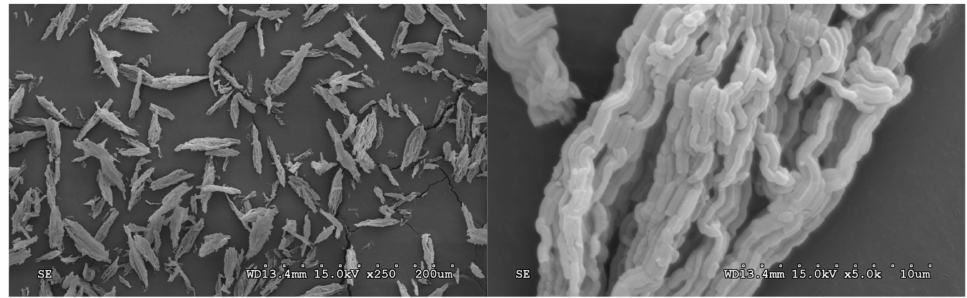
Figure 15. SEM micrographs of the synthesized SBA-15 in the scaling